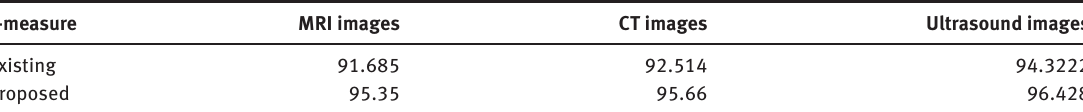
Table 2: Comparison of Proposed and Existing F -Measures.